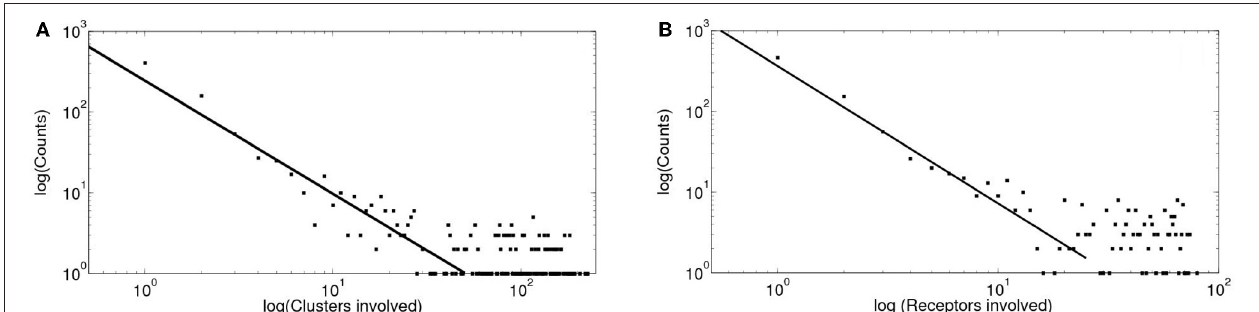
FIGURE 7 | Distributions of clusters and of receptors involved obtained with simulations of intercluster dynamics with calcium accumulation. (A) Distribution of the number of clusters involved in each signal displayed on a logarithmic scale. By fitting a power law relationship to some of the data points we obtain exponents between 1 and 1.4 with R 2 between 0.72 and